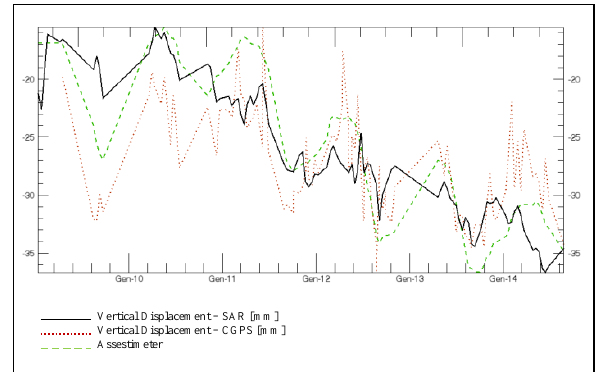
Figure 12. S.S.U. (SAR, CGPS), assestimeter and piezometer measures